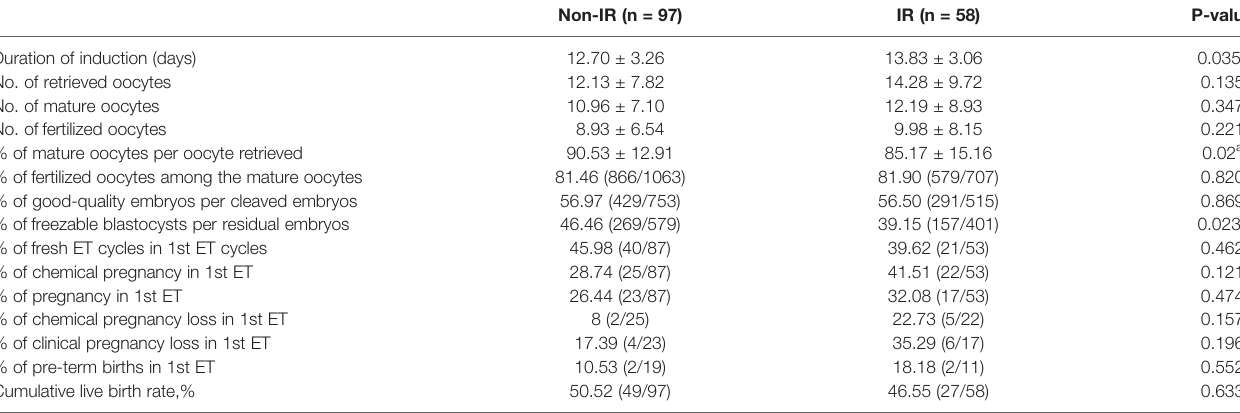
TABLE 3 | Oocyte and embryological data after IVF-ET treatment between insulin resistant (IR) and non-insulin resistant (Non-IR) infertile women. Non-IR (n =